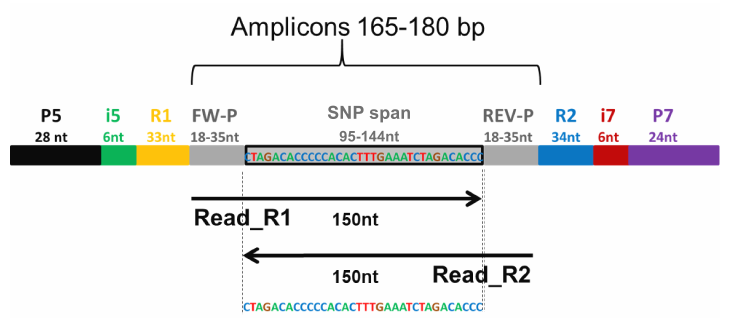
Figure 2. PotatoMASH library structure in relation to paired-end 150nt Illumina reads Read_R1 and